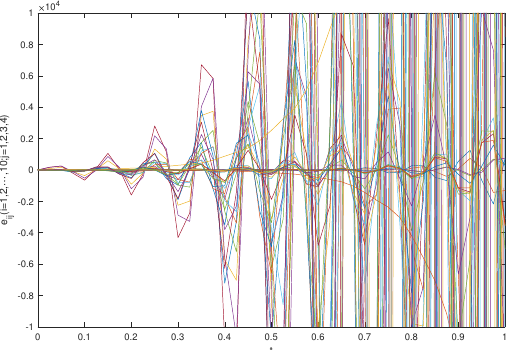
Figure 19. Synchronization errors e ij ( i = 1,2, · · · ,10; j = 1,2,3,4 ) of the fractional-order system (34) and (35) without the controllers.